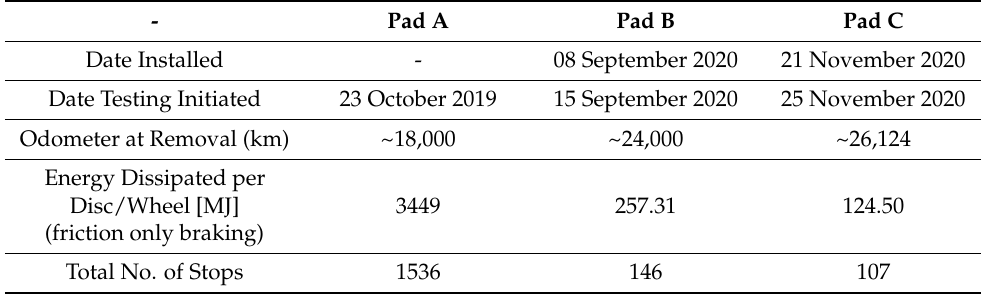
Table 1. Brake pad set usage of the tested